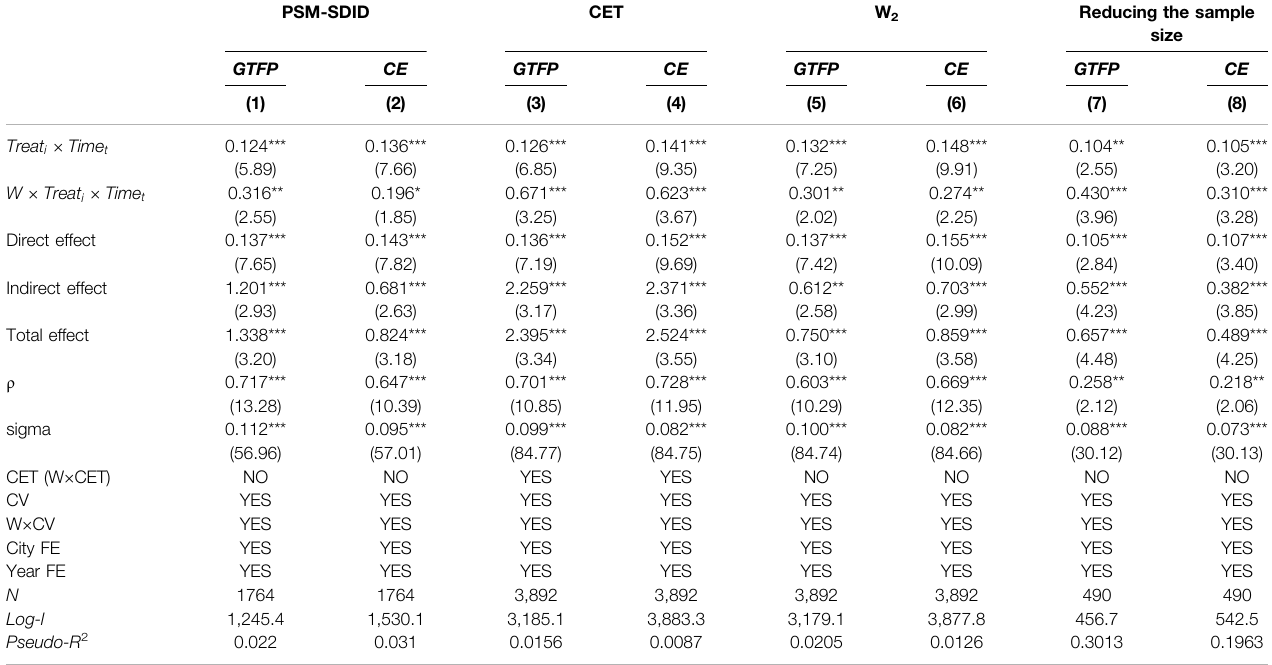
TABLE 7 | Robustness test Ⅱ